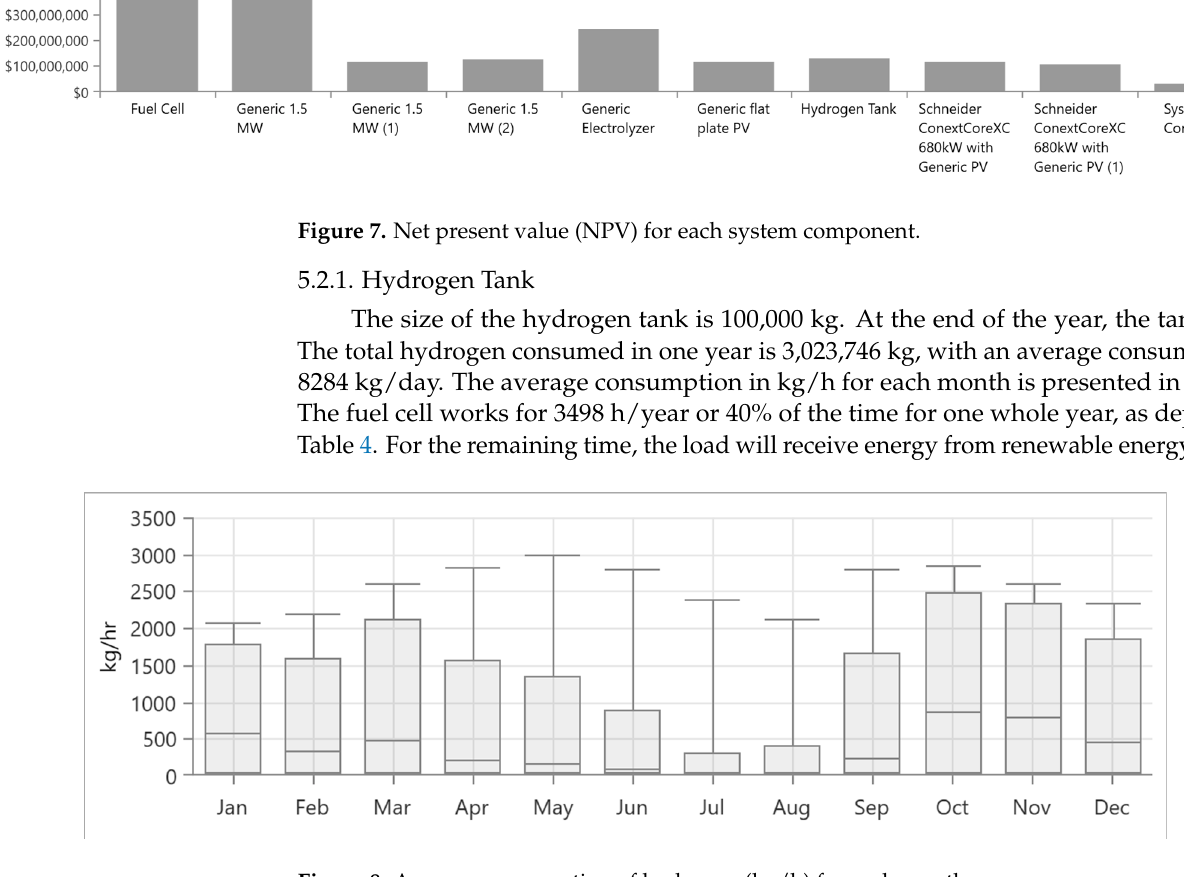
Figure 8. Average consumption of hydrogen (kg/h) for each month. Table 4. Fuel cell